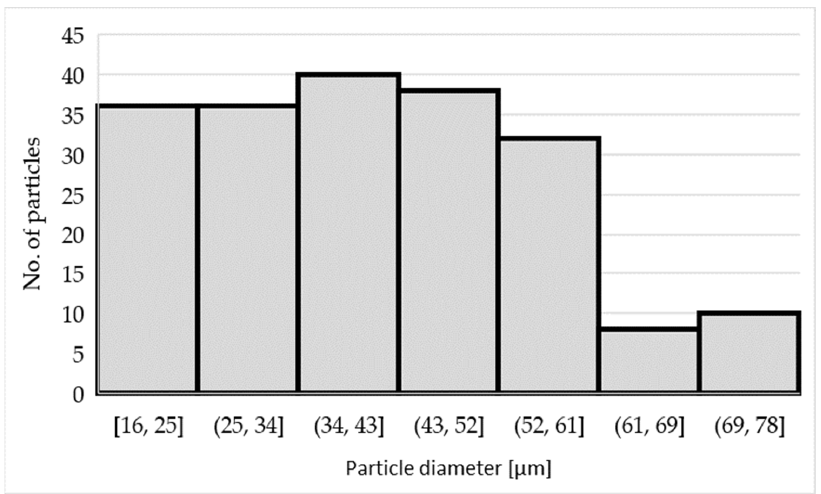
Figure 6. Histogram of the particle size distribution of the TiAl 3 phase in the AlTi3B1